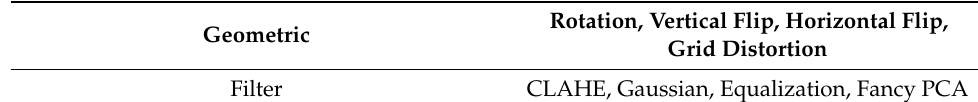
Table 2. Applied data argumentation techniques.